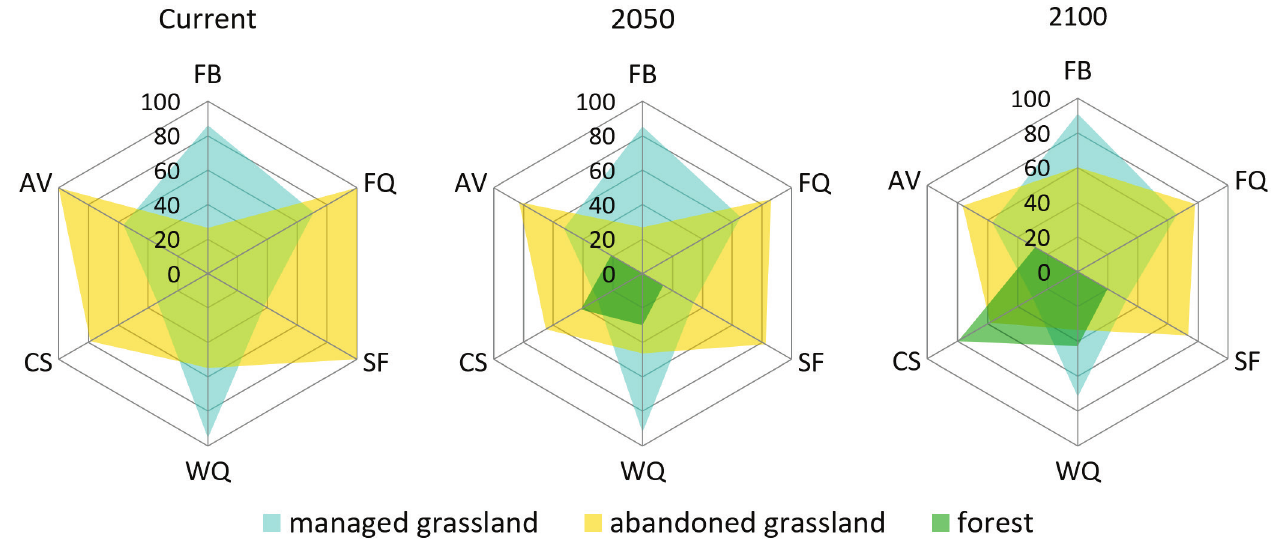
Figure 4. Predicted shifts in ES of mountain grassland in the Stubai Valley (Austria) until 2050 and 2100 under a trend scenario (projecting current trends into the future). ES include FP – forage production, FQ – forage quality, SF – soil fertility, WQ – water quality, CS – carbon storage, AV – aesthetic value. Increasing forest cover results from natural reforestation of abandoned grassland. Modified from Schirpke et al.